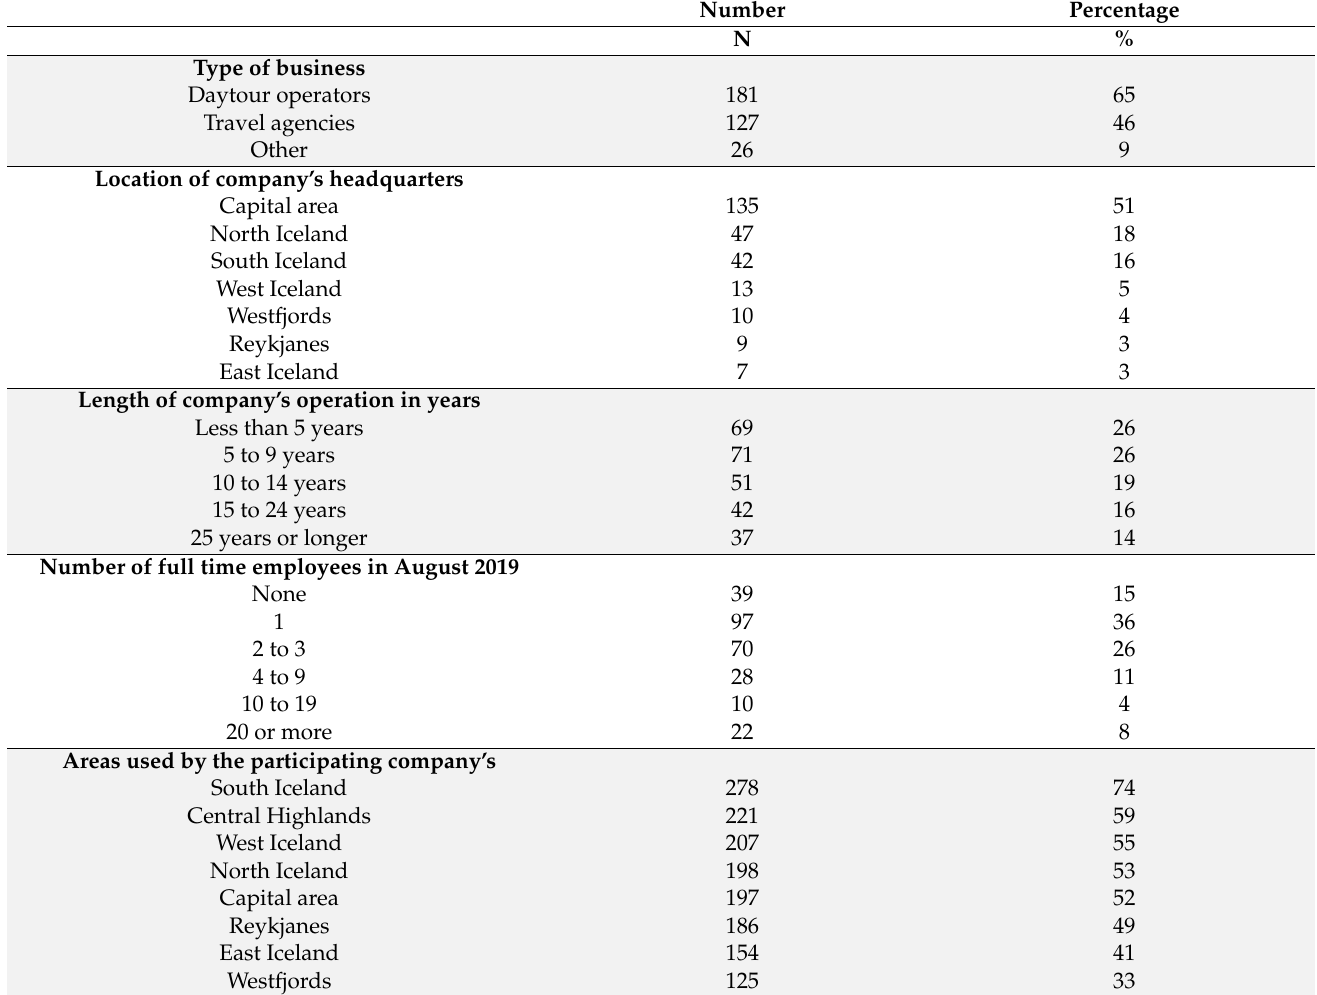
Table 1. Characteristics of the tourism companies which participated in the